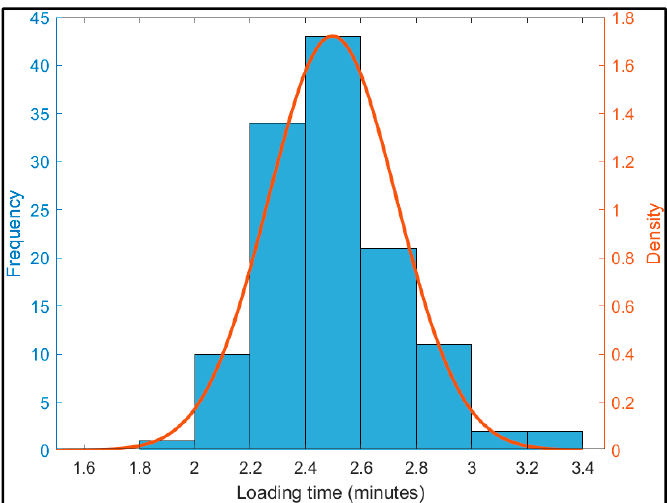
Figure 11. Cycle time durations of dump trucks.